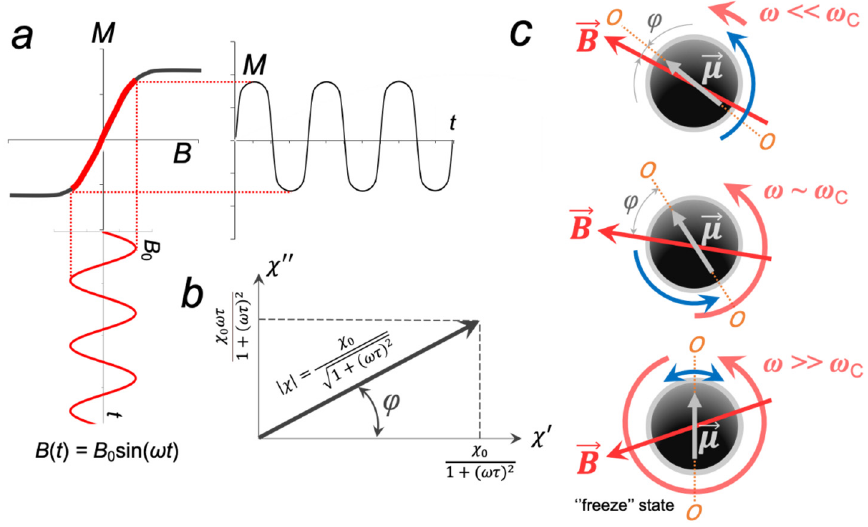
Figure 4. Dynamic response of an MNP to an applied external AMF: ( a ) magnetization response of an MNP to an alternating sinusoidal field B ; ( b ) frequency-dependent magnetic susceptibility of an MNP, where τ is the effective relaxation time, χ (cid:48) and χ (cid:48)(cid:48) are the real and the imaginary parts of magnetic susceptibility, respectively; ( c ) dynamic behavior of the MNP magnetic moment 𝜇⃗ in AMFs of various frequencies.